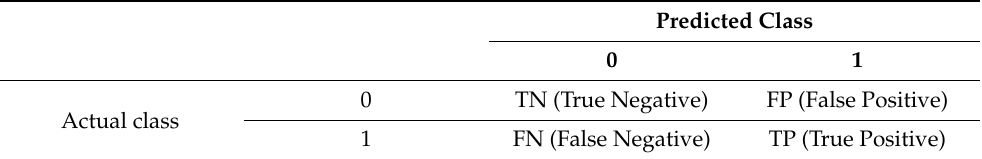
Table 3. Confusion